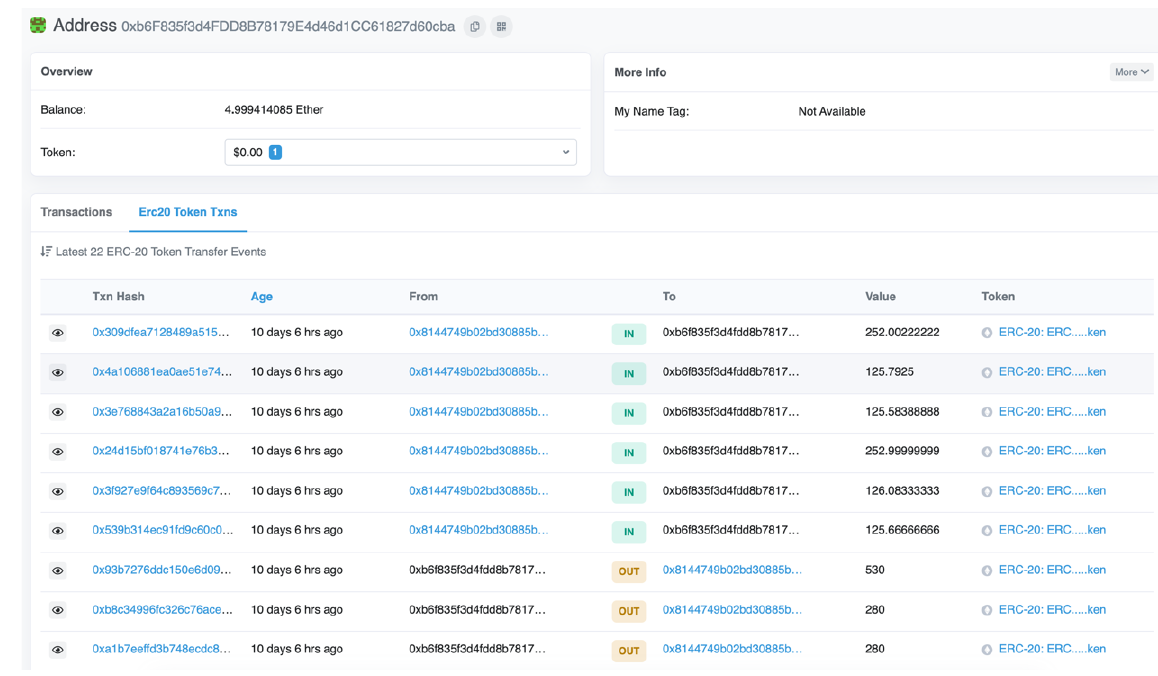
Figure A22. Proof of providing fund with right-type CTs information on Etherscan.